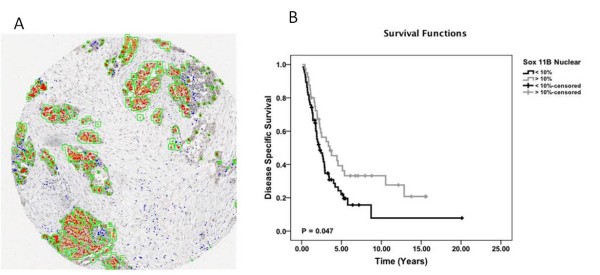
IHC and survival analyses of SOX11. (A) Representative nuclear SOX11 staining identified using an automatic tumor specific algorithm showing nuclear expression in red. (B) Kaplan-Meier analysis and the log rank test identified SOX11 as significant associated (p = 0.047) with cancer specific survival in high grade tumours, including tumours with low differentiation grade. The patients were classified into two groups based on SOX11 expression.